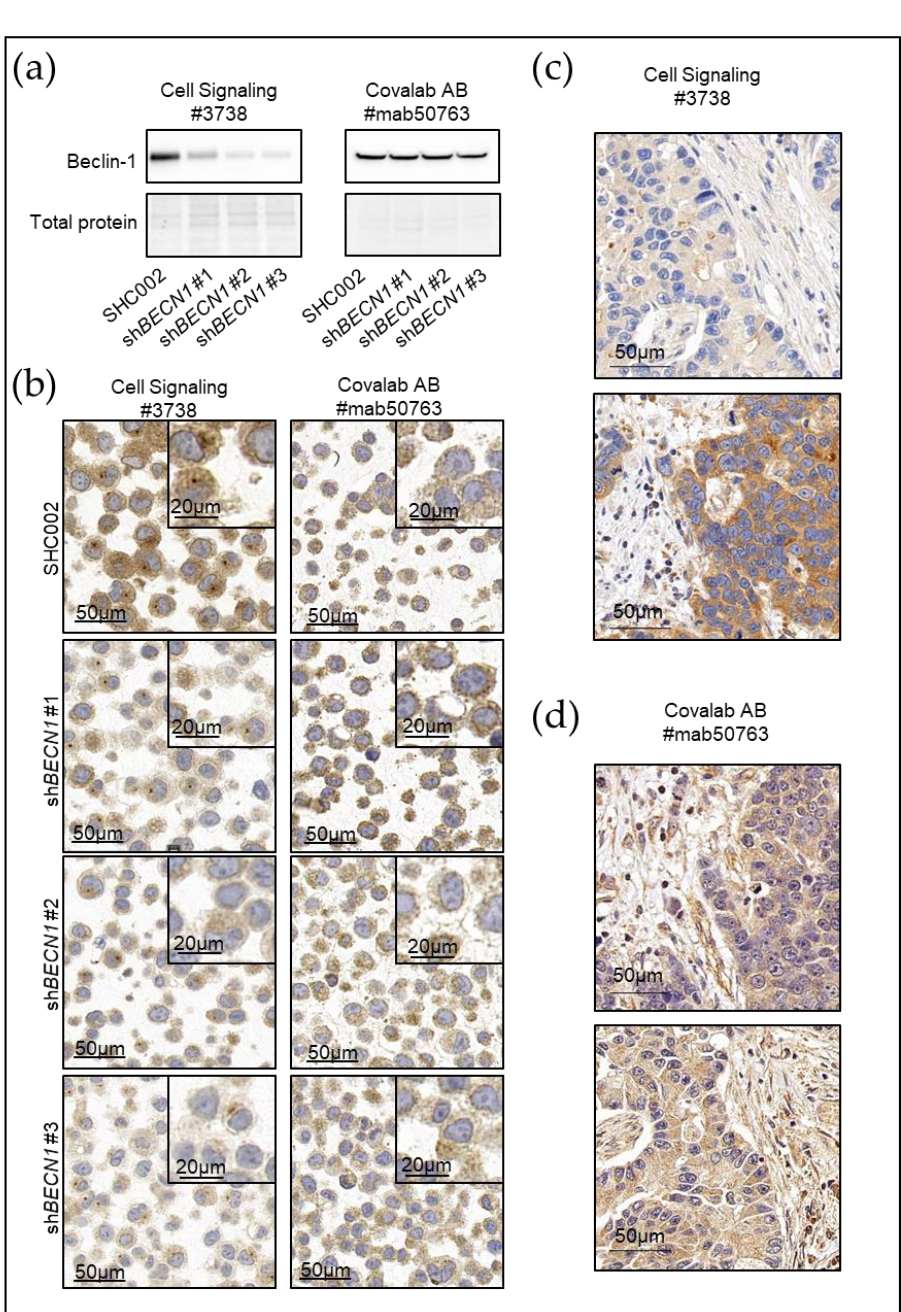
Figure 2. Specificity test of two different anti-Beclin-1 antibodies in FLO-1 human oesophageal adenocarcinoma cells and in primary gastric cancer. FLO-1 cells were transduced with a non-targeting, scrambled shRNA (SHC002) or 3 independent shRNAs targeting BECN1 . ( a ) Total lysates were subjected to immunoblotting using anti-Beclin-1 from Cell Signaling Technologies (left panel) or Covalab (right panel). Stain-Free Total protein is shown as a loading control, ( b ) cell pellets were fixed and